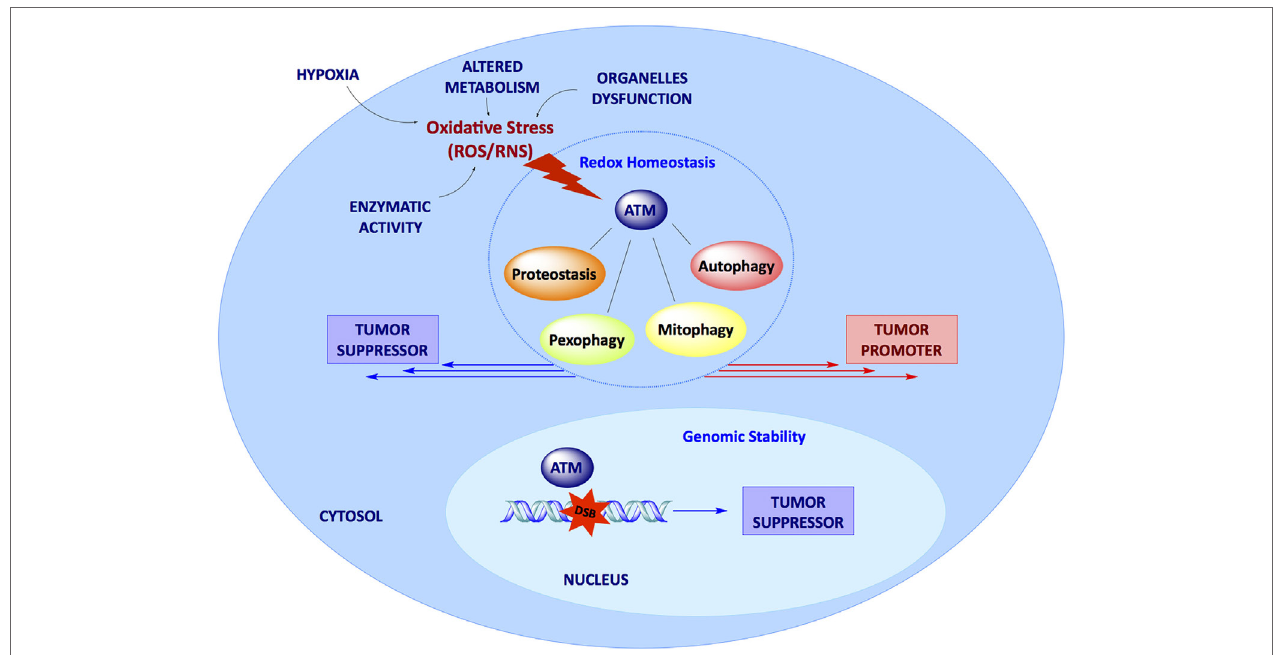
FiGURe 1 | Dual role of ataxia-telangiectasia mutated kinase (ATM) in cancer. In the nucleus, DBSs activate ATM kinase, which ensures genomic stability, acting as a tumor suppressor factor. In the cytosol, ATM acts as a stress sensor, being activated upon oxidative stress to maintain intracellular redox homeostasis. Here, ATM is responsible for protein quality control and regulates several pathways such as autophagy and organelles selective removal (mitophagy and pexophagy). All these pathways may promote or prevent tumor growth depending on the specific context; the molecular mechanisms underlying the dual function of ATM still deserve further